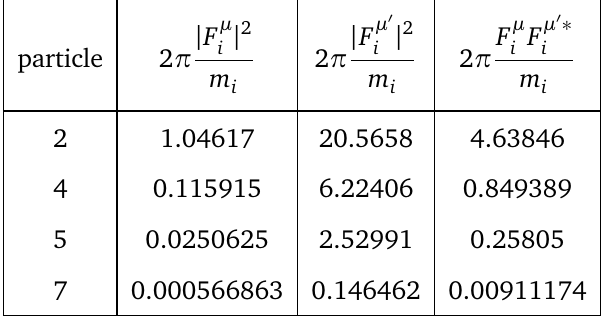
Table 7.2: One-particle weights in the contributions to the DSF